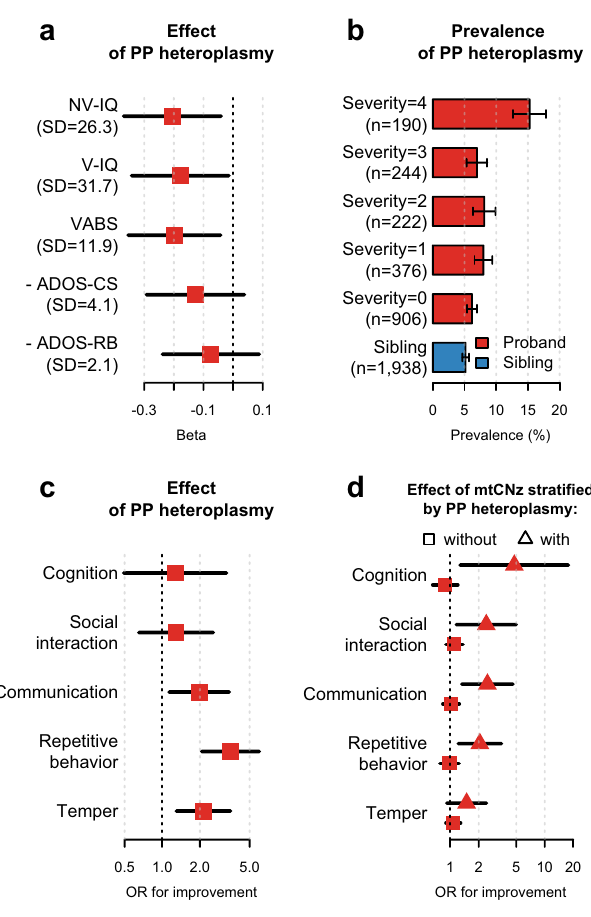
Fig. 5 Association of mtDNA heteroplasmies and mtDNA content with neurodevelopmental traits among probands in the SSC. a Forest plots for the effects of carrying predicted pathogenic (PP) heteroplasmies on ASD- related neurodevelopmental traits among probands ( n = 1938 for all traits). Beta refers to the standardized coef fi cient, and negative values indicate worse functions. The standard deviation (SD) of each trait is indicated in parentheses. b Bar plots for the family-adjusted prevalence of PP heteroplasmies among probands and siblings. Probands were grouped according to the severity level computed using the equation: (NV- IQ < 70) + (V-IQ < 70) + (VABS in the bottom 25%) + (- ADOS-CS in the bottom 25%). c Forest plots for the odds ratios (ORs) of carrying PP heteroplasmies for improvements in ASD-related symptoms among probands (from top to bottom, n = 1502, 1512, 1510, 1512, and 1516). d Forest plots for the favorable effects of per standard deviation increase in the mtDNA content z-score (mtCNz) among probands without PP heteroplasmies (from top to bottom, n = 1383, 1391, 1389, 1390, and 1395) and among probands with PP heteroplasmies (from top to bottom, n = 119, 121, 121, 122, and 121). Horizontal black lines represent the 95% con fi dence interval of the effect sizes. Error bars in b represent bootstrapped SEM. Values on the x axes in c and d are shown on a logarithmic scale.